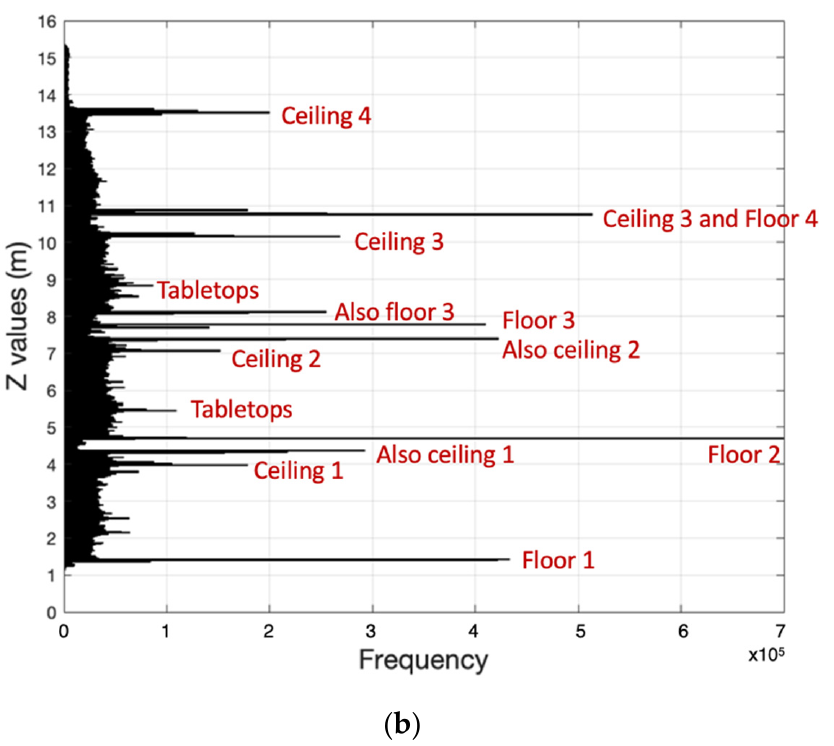
Figure 2. Vertical histogram examples: ( a ) Building with single-level storeys; ( b ) Building with multi-level storeys.